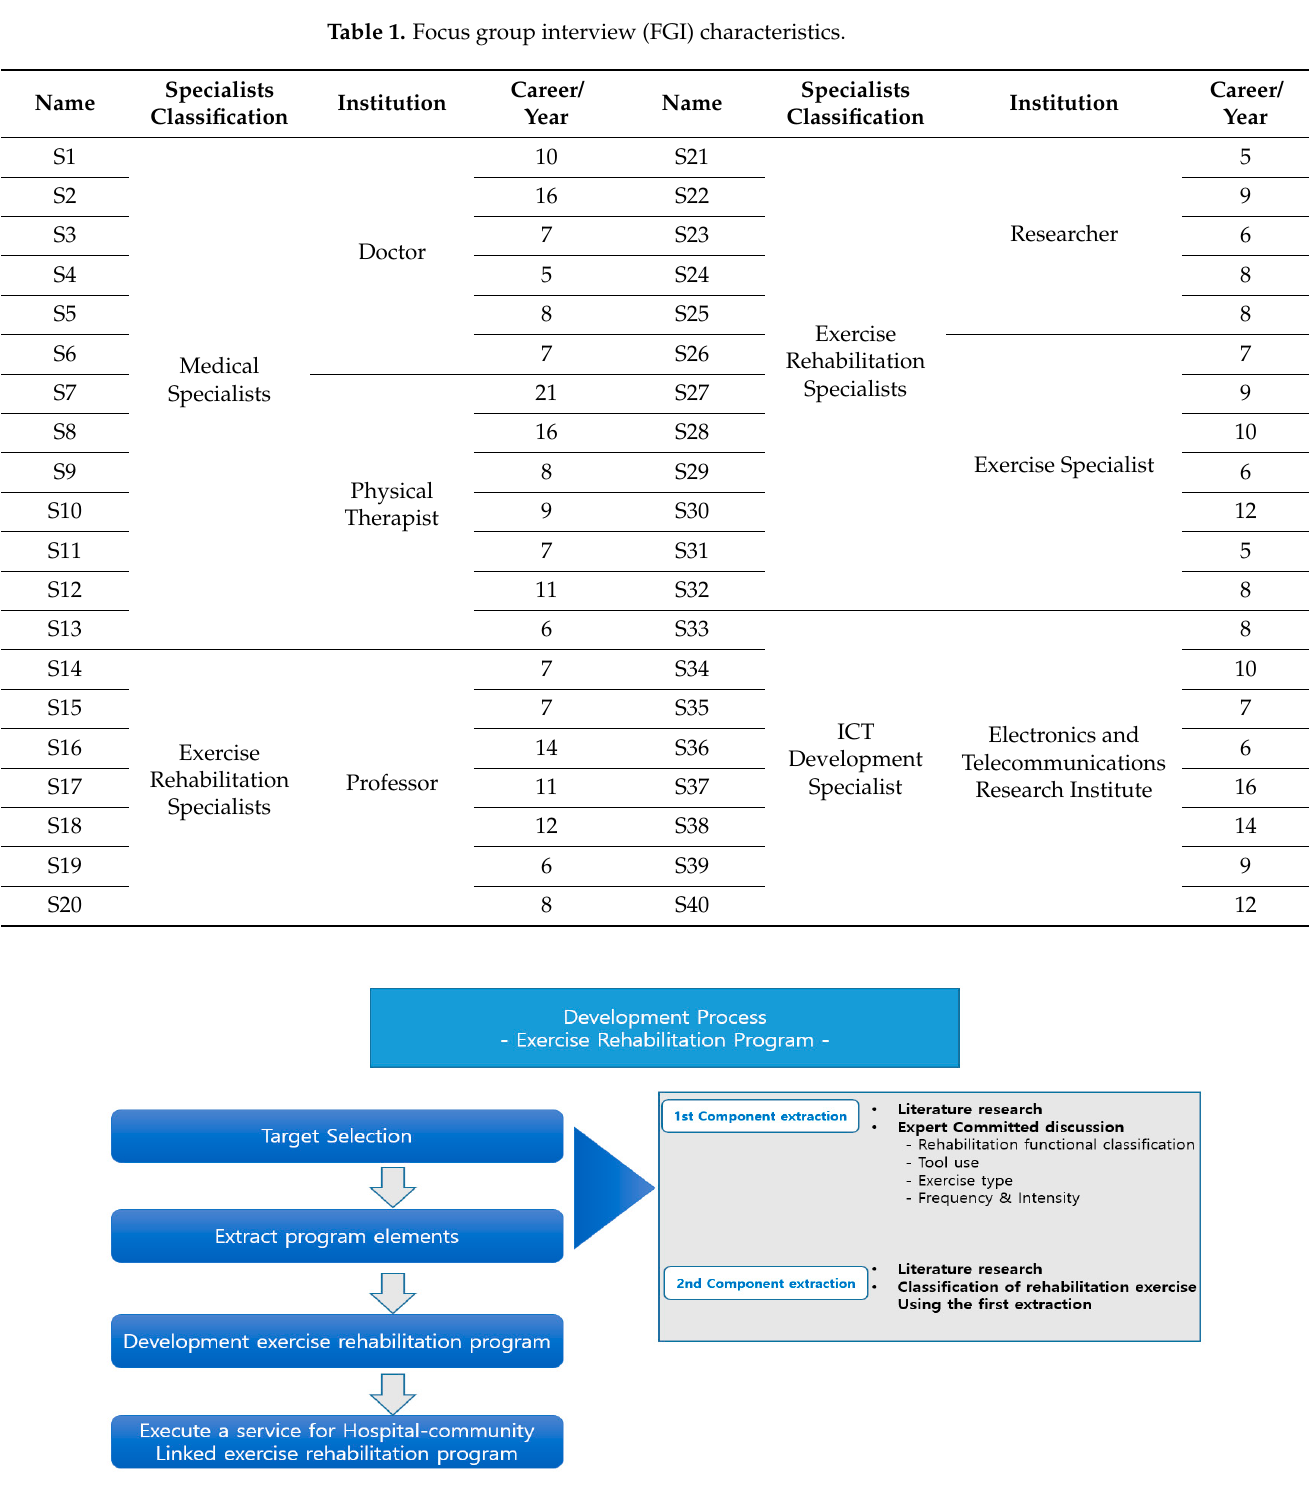
Table 1. Focus group interview (FGI) characteristics.